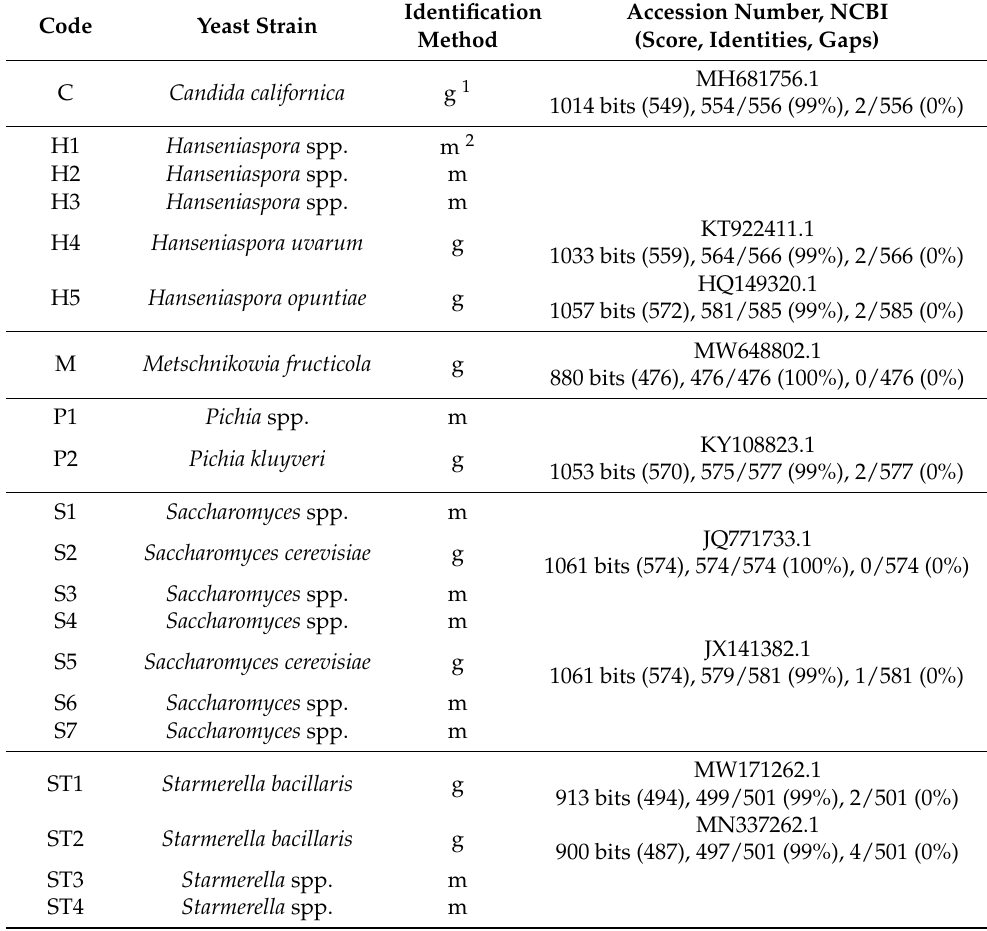
Table 1. Yeast strains isolated from red grape pomace and